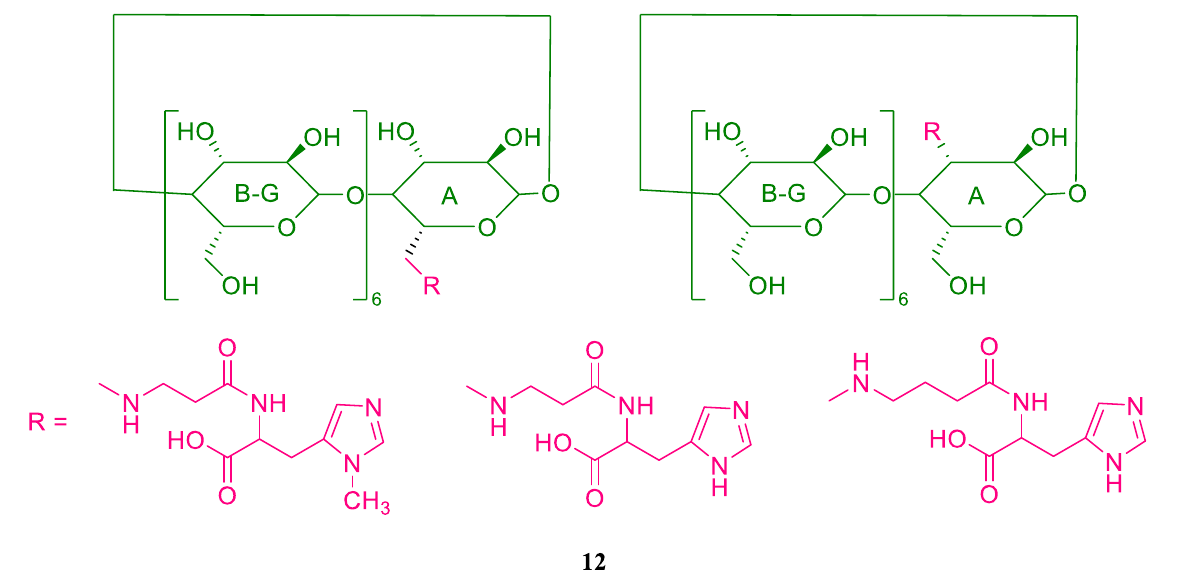
Figure 20. Glycosidic analogues of His dipeptides.